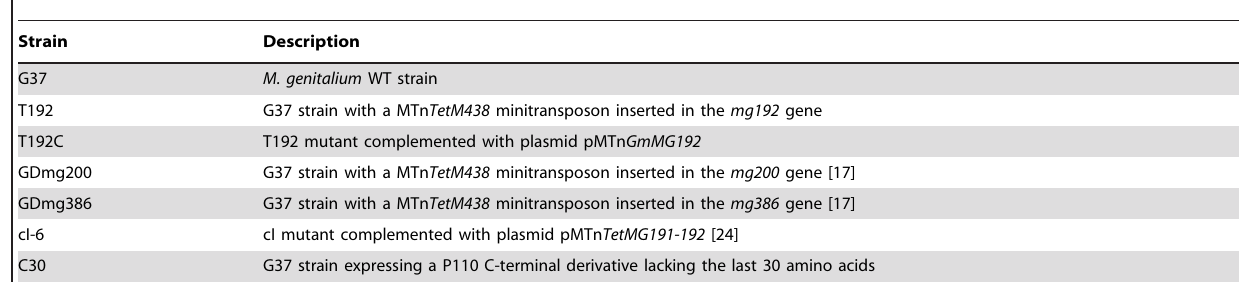
Table 2. Strains used in this